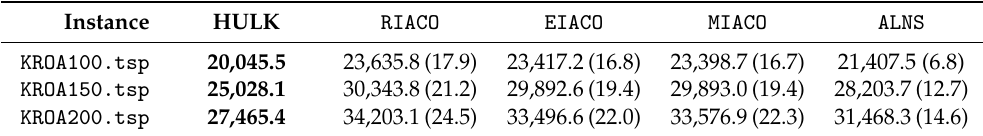
Table 2. Comparison of HULK and four immigrant schemes from literature. The number between brackets means the distance in percentage from the current value to the best value, in boldface.